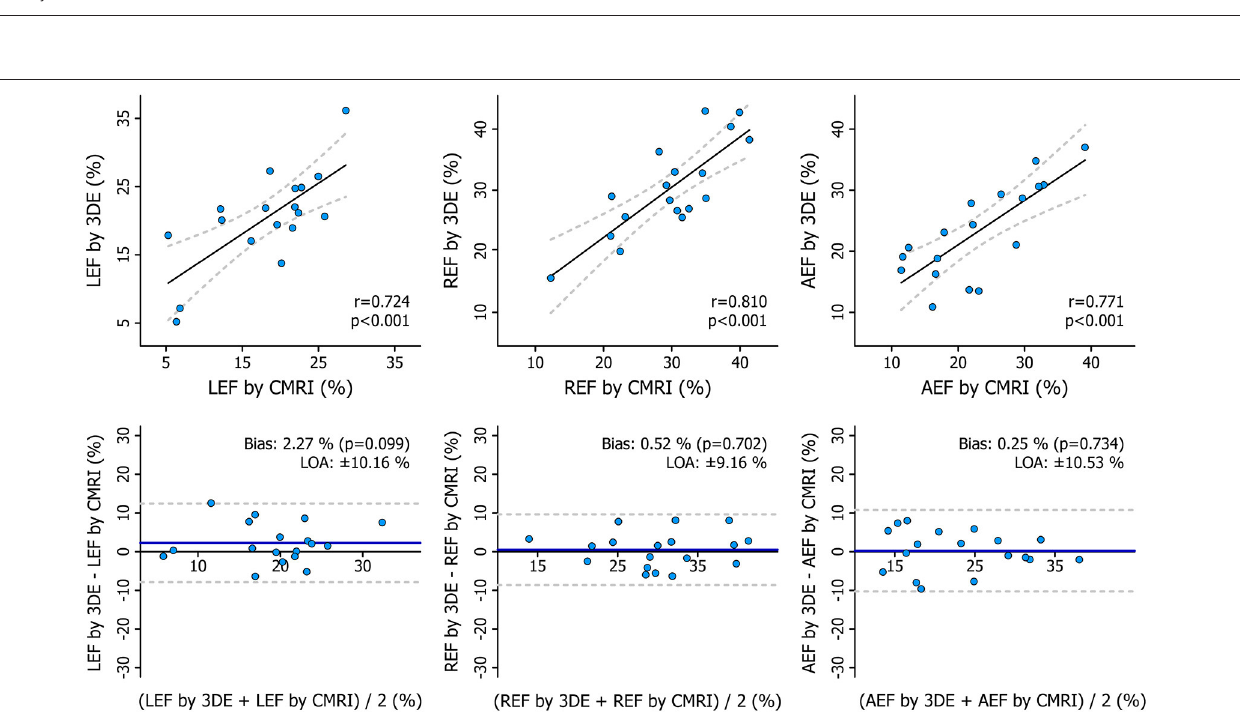
FIGURE 10 | Correlation and agreement between 3D echocardiography- and cardiac magnetic resonance imaging-derived measurements of right ventricular decomposed ejection fractions depicted by correlation and Bland–Altman plots. Statistical tests: same as in Figure 8 . 3DE, 3D echocardiography; AEF, anteroposterior ejection fraction; CMRI, cardiac magnetic resonance imaging; LEF, longitudinal ejection fraction; LOA, limits of agreement; REF, radial ejection fraction.